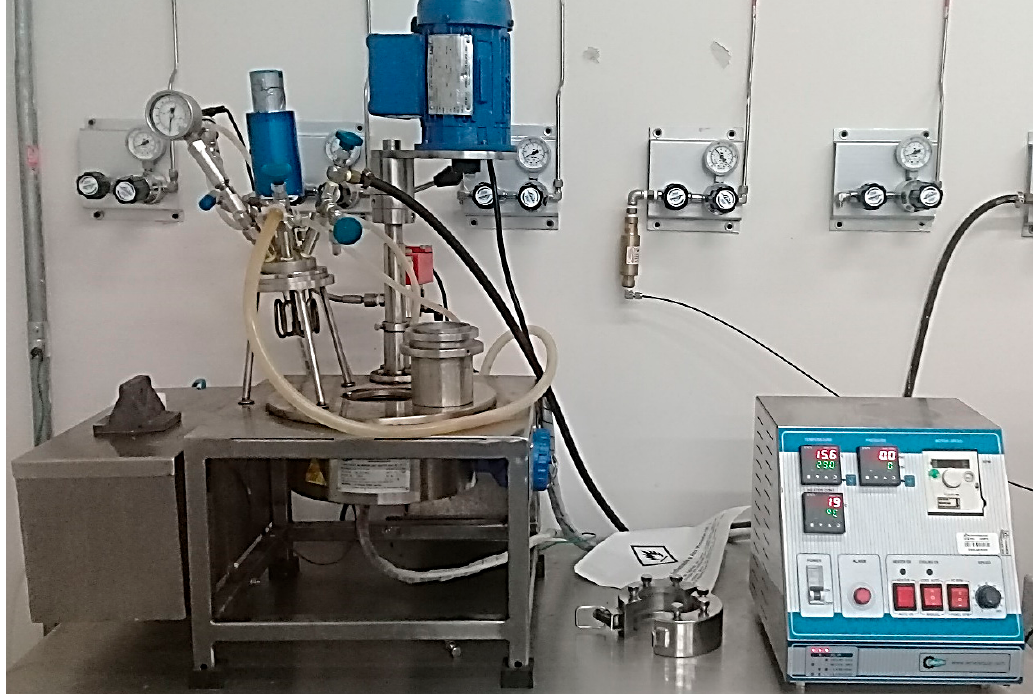
Figure 1. Stirred tank batch reactor.